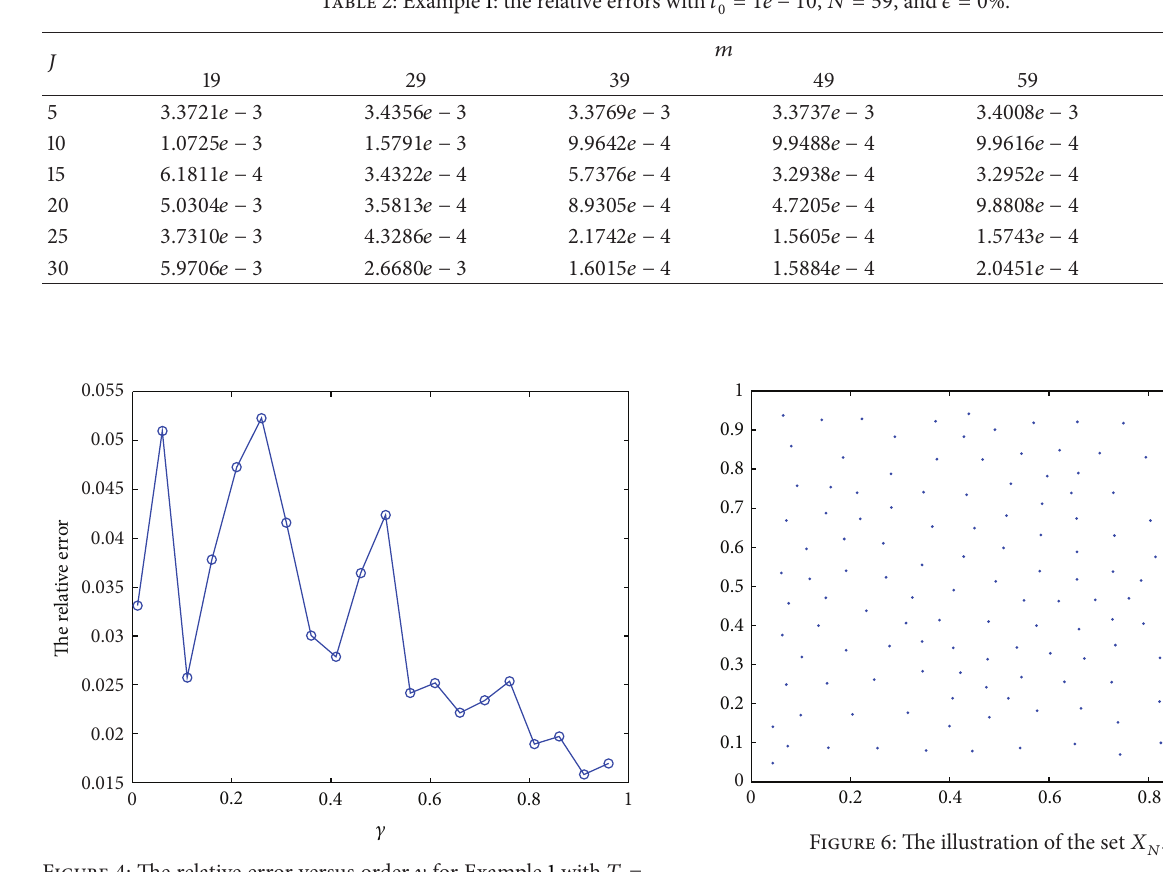
Figure 4: The relative error versus order 𝛾 for Example 1 with 𝑇 = = 1𝑒 − 10 for noise 𝜖 = 1 %. 0.5 , 𝑚 = 59 , 𝑁 = 59 , and 𝑡 0